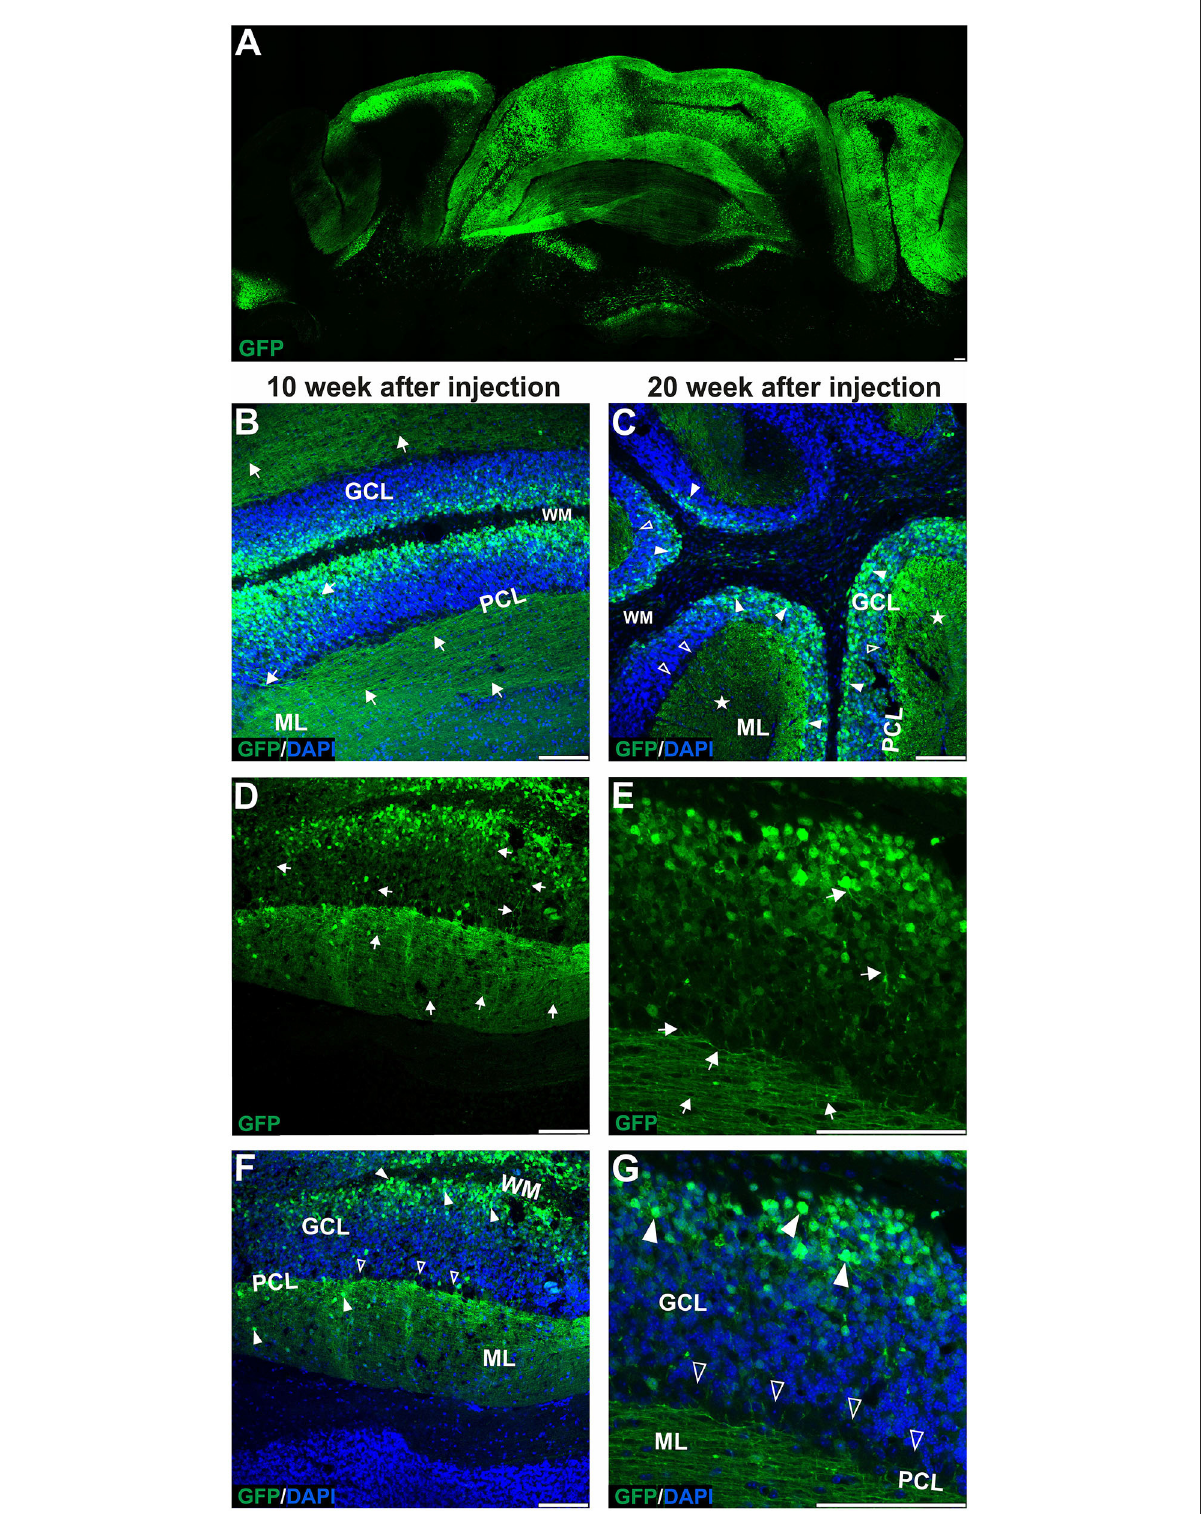
FIGURE2 The late transduction phase of the mouse cerebellum after injection of the eGFP-encoding AAVrh10 vector into cerebellar lobules. The imaging of eGFP + cells was performed after 10 (B,D,F) and 20 weeks after injection (A,C,E,G) and demonstrated densely packed round transduced